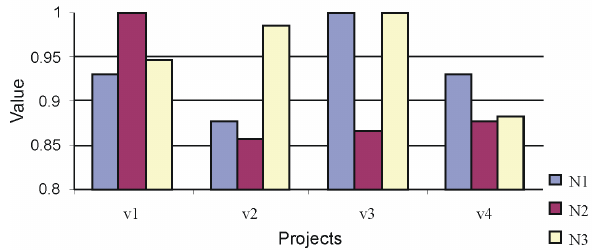
Fig. 6. Calculation results according to COPRAS-G method